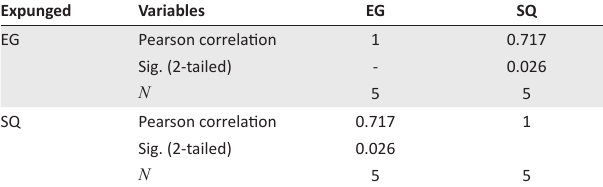
TABLE 6: Correlations: Relationship between e-governance and service quality.